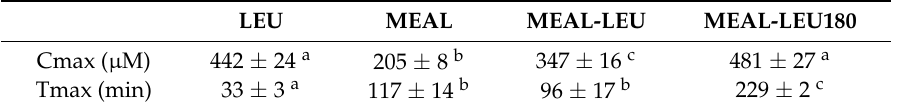
Table 5. Plasma leucine concentration of the pharmacokinetics